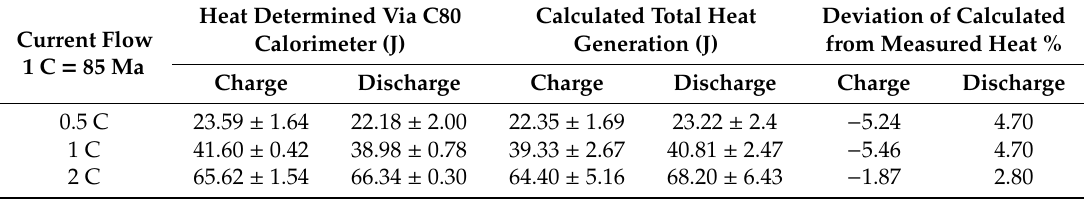
Table 3. Calculated and measured total heat generation during cycling with various C-rates. Current Flow Current